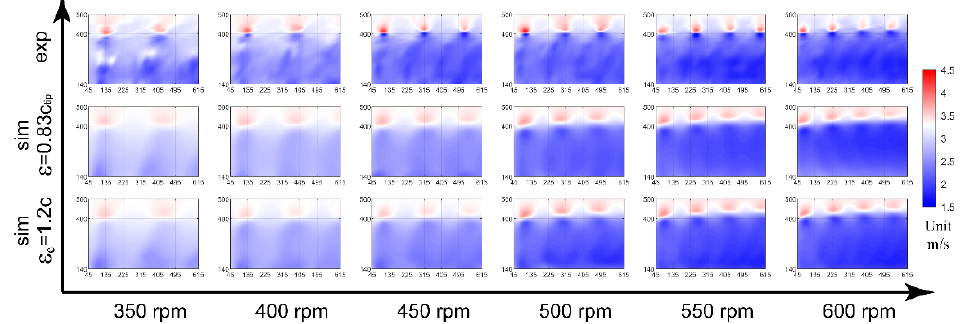
Figure 18. The velocity magnitude contour of the plane along with the main flow. The origin is the rotor center. The data area is from 45 mm to 615 mm behind the rotor and 140 mm to 500 mm away from the main shaft.